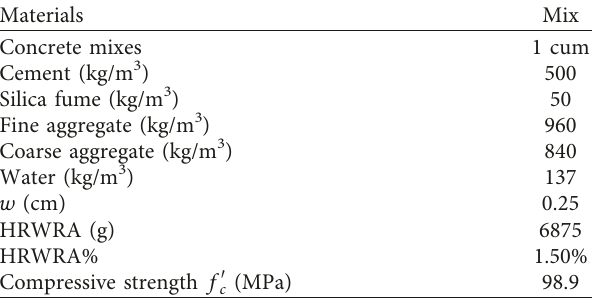
Table 5: Composition of concrete mix.